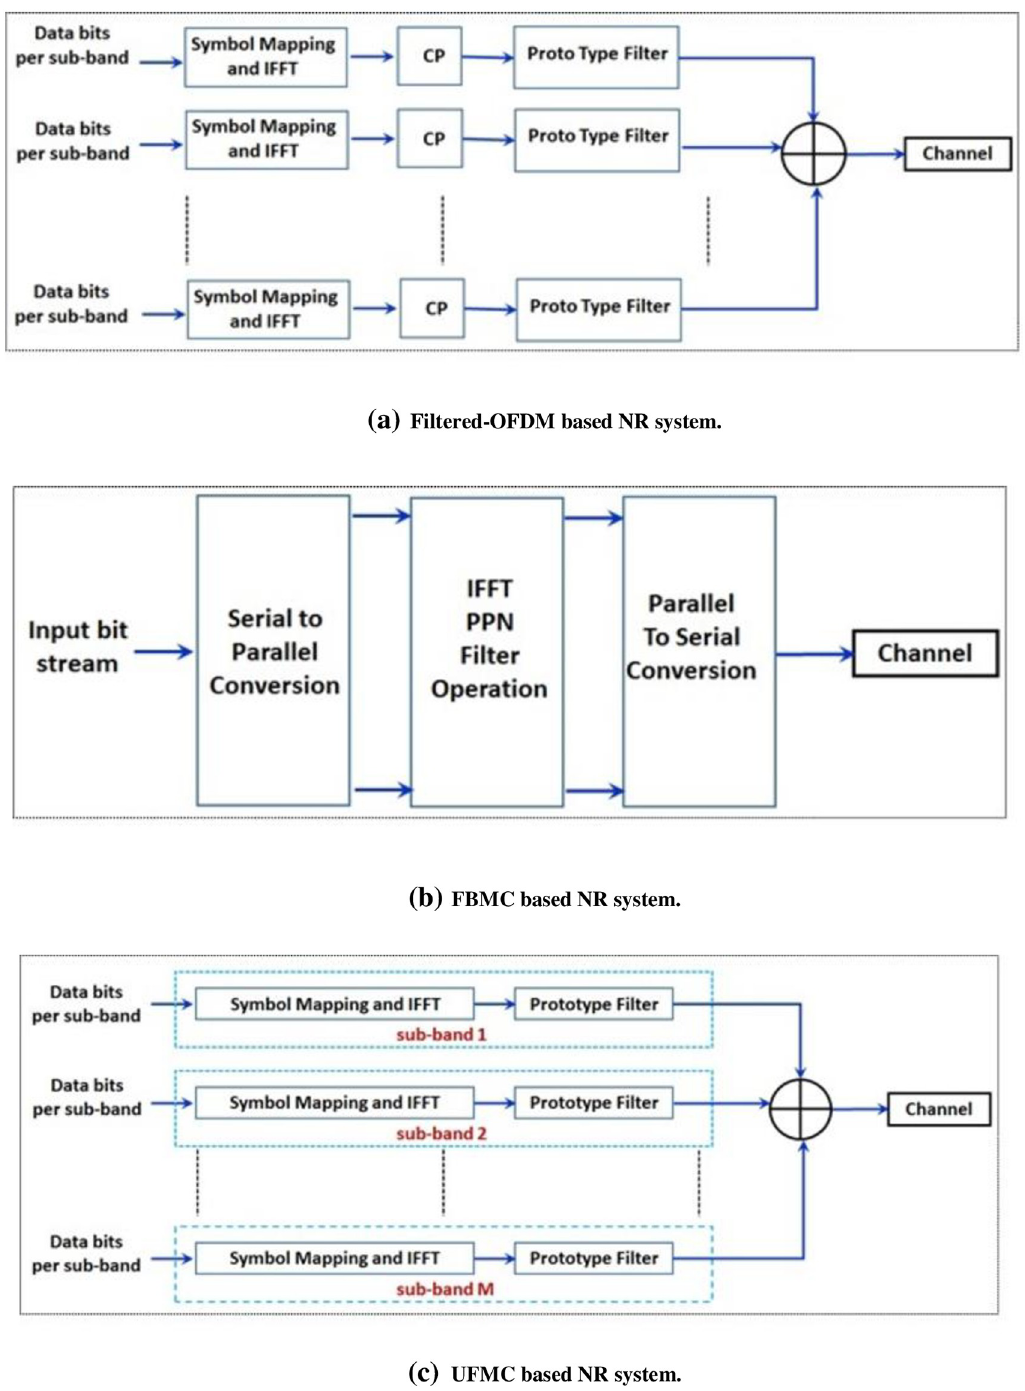
Fig 2. Block diagrams of different NR interfaces at the transmitter sides. (a) Filtered-OFDM based NR system. (b) FBMC based NR system. (c) UFMC based NR system.